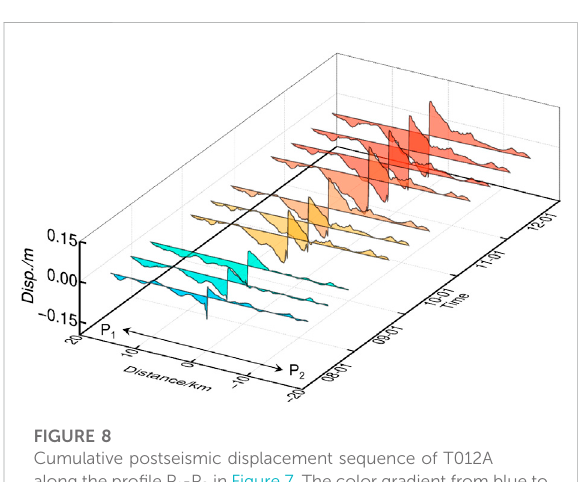
FIGURE 8 Cumulative postseismic displacement sequence of T012A along the pro fi le P 1 -P 2 in Figure 7. The color gradient from blue to red indicates amplitude of the displacement increment over